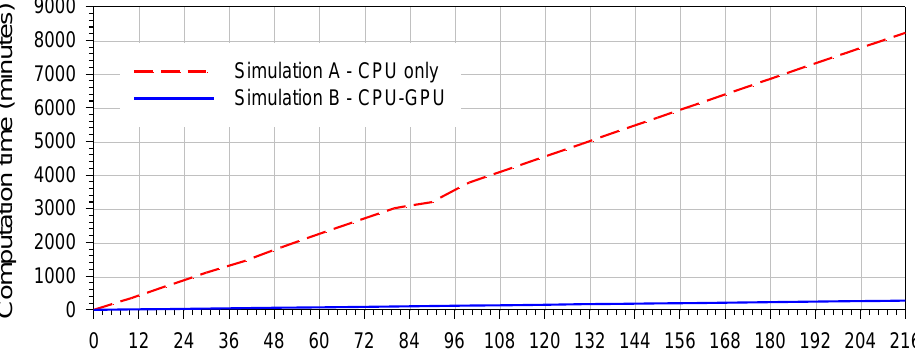
2003, computation time 8226 min (~137 h); simulation B (CPU + GPU): actual transitory